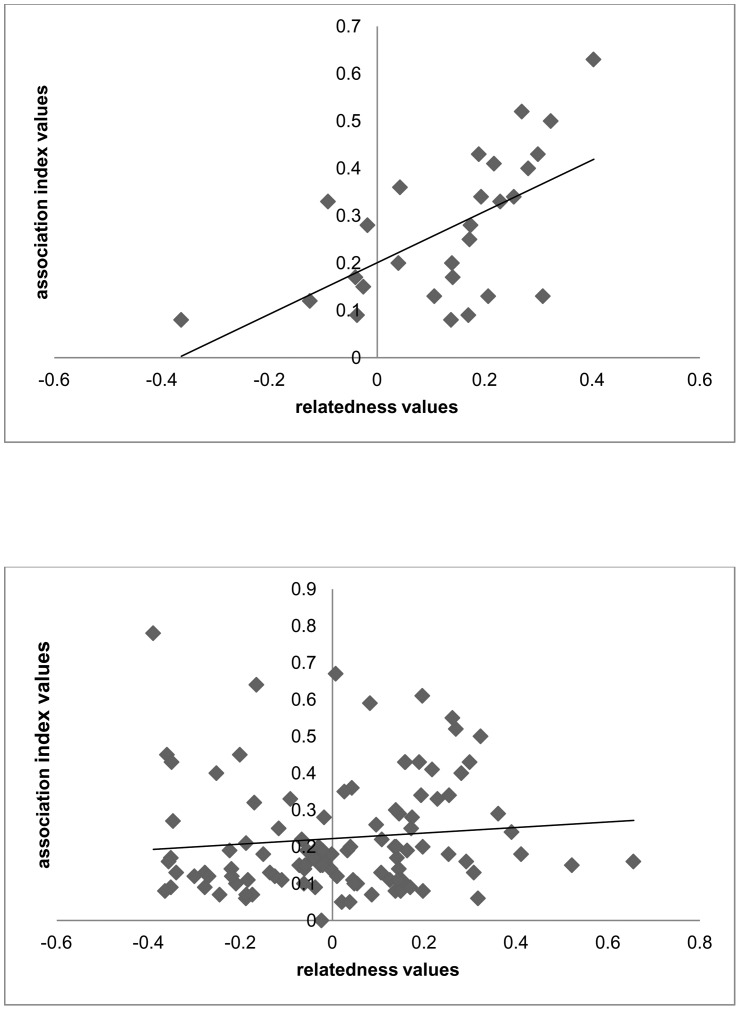
Association Index and relatedness values.Association Index values (Half-Weight Index [26]) plotted against relatedness values for (a) leader-follower dolphin pairs and (b) non leader-follower pairs in the Lower Florida Keys (leader-follower: n = 57, rs = 0.55, P<0.0001, non leader-follower: n = 81, rs = 0.07, P = 0.51).